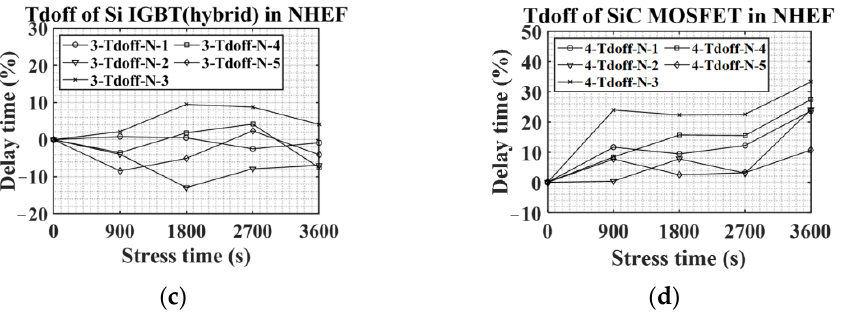
Figure 19. T doff variations in NHEF stress: ( a ) Si IGBT, ( b ) Si MOSFET, ( c ) Si IGBT with SiC diode, and ( d ) SiC MOSFET. Table 3. Threshold voltage, on-resistance, turn-on delay, and turn-off delay variations according to switch types under HEF stress.